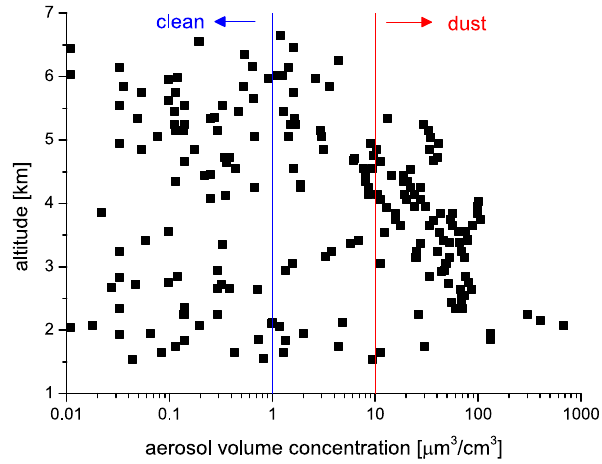
Figure B1. Vertical distribution of aerosol volume concentration ( V 10 ) measured above the boundary layer during the six aircraft flights.